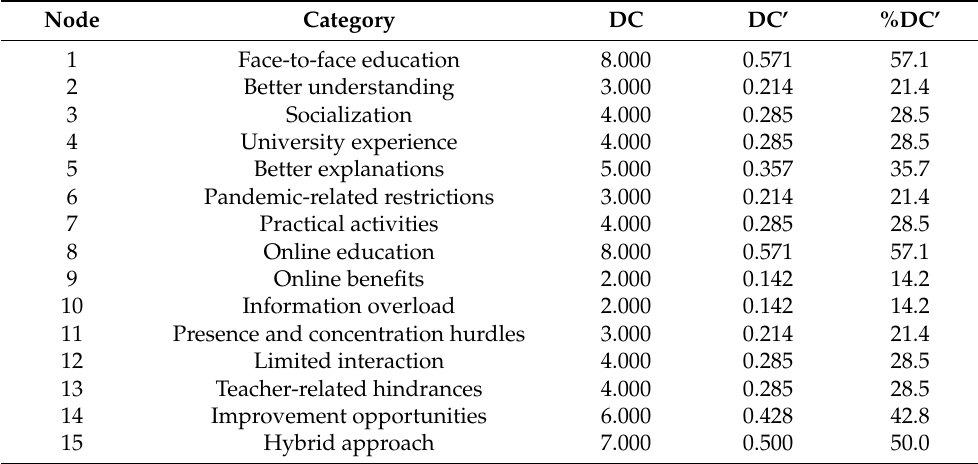
Table 3. The degree of centrality for the 15 nodes